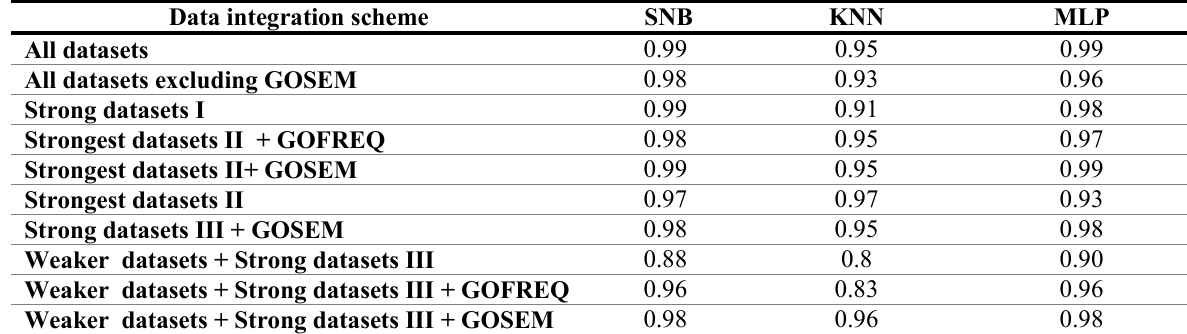
Table 4. AUC values for each machine and statistical learning method with different integrations of the